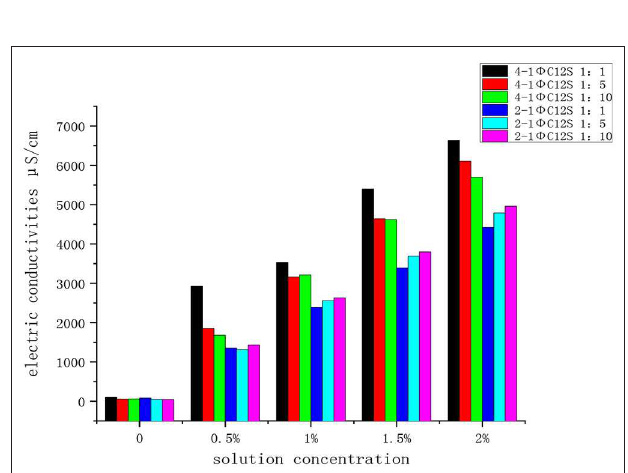
FIGURE 11 | Conductivity test